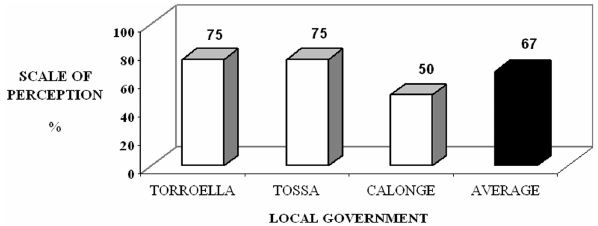
Fig. 4. Perception of vulnerability to flooding. Local